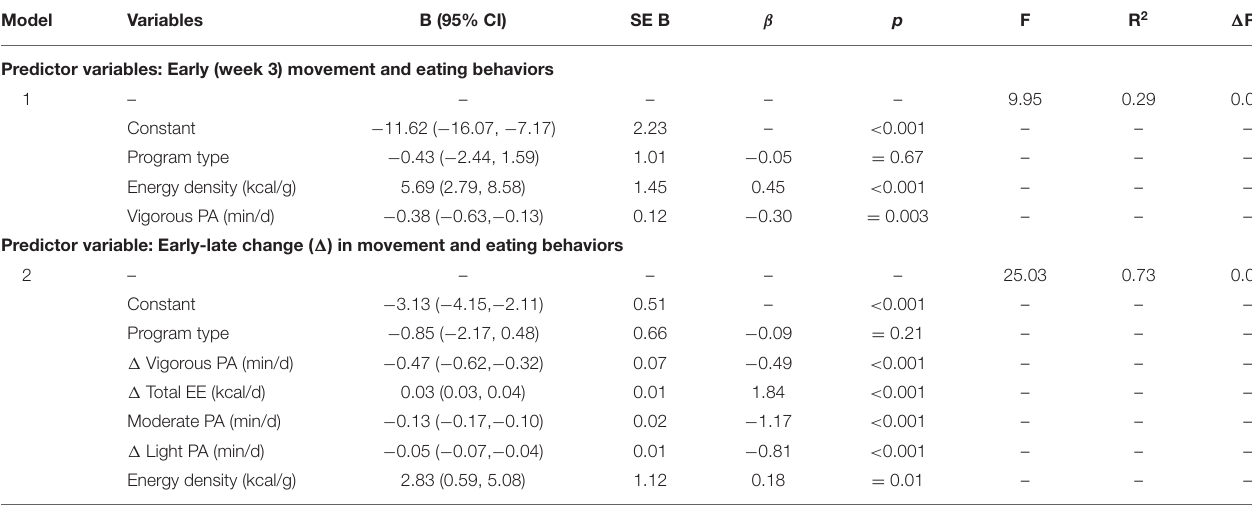
TABLE 2 | Hierarchical linear regression analyses predicting change in percentage BM between baseline and week 14 from week three movements and eating behaviors and from early-late change in movement and eating behaviors.